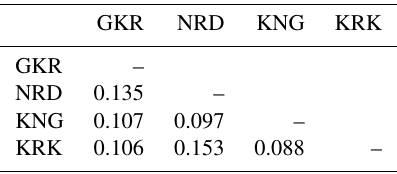
Table 4. Nei’s (1987) genetic distance values among populations.